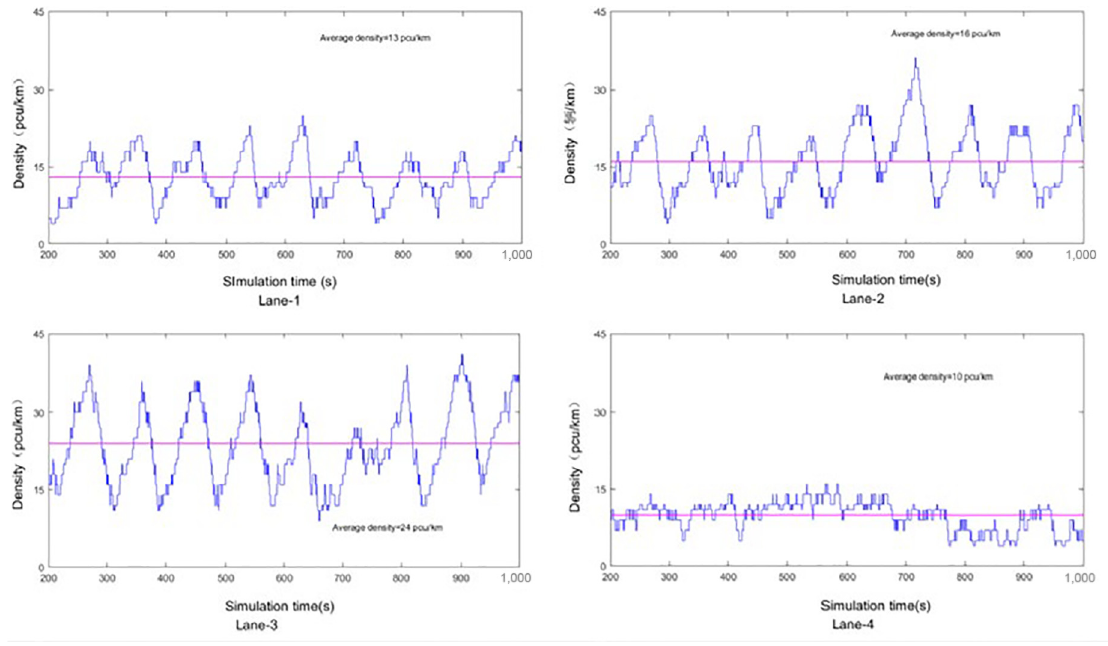
Figure 8 Real-time traf fi c density of lanes in ordinary traf fi c